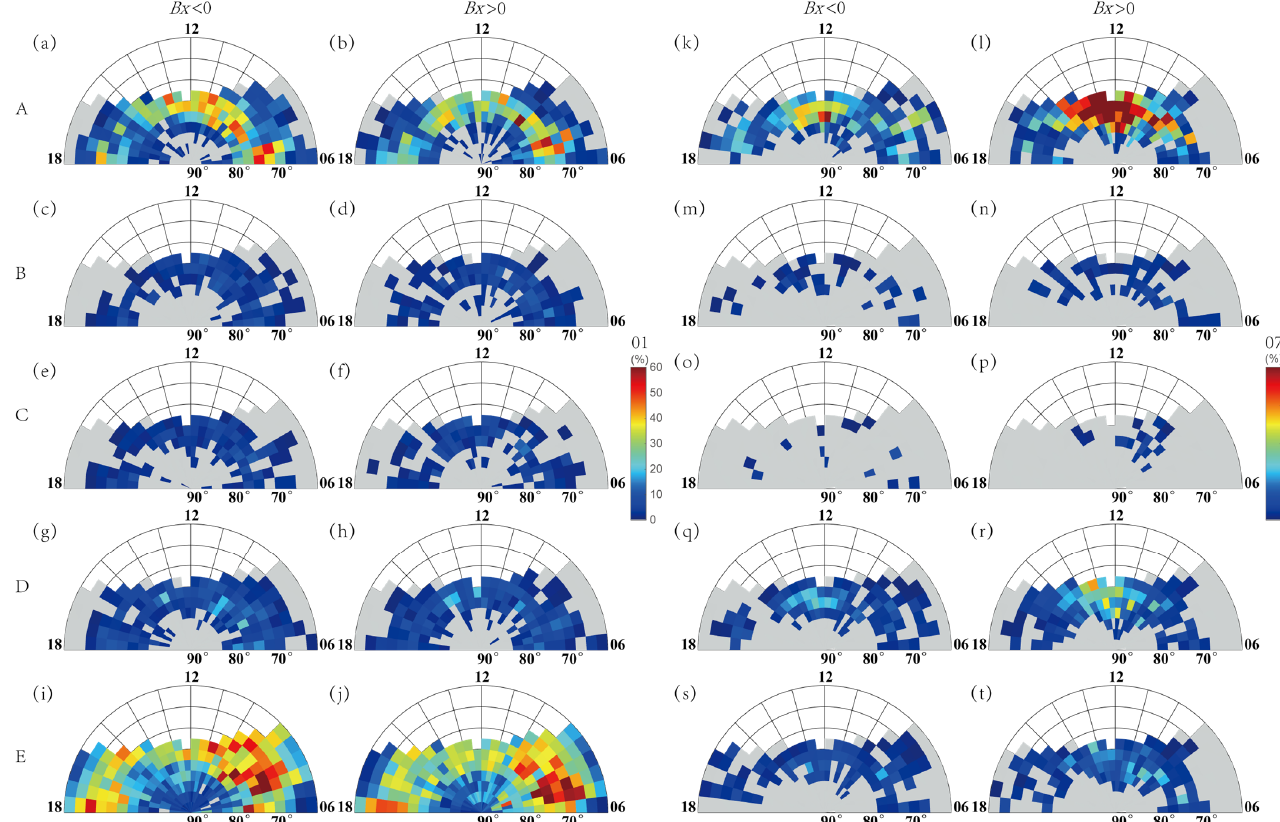
Figure 5. Temporal–spatial distribution of different types of ion upflows under different direction of IMF Bx . From top to bottom are ion upflows of type A to E, respectively. ( a – j ) statistics for January, ( k – t ) statistics for July.